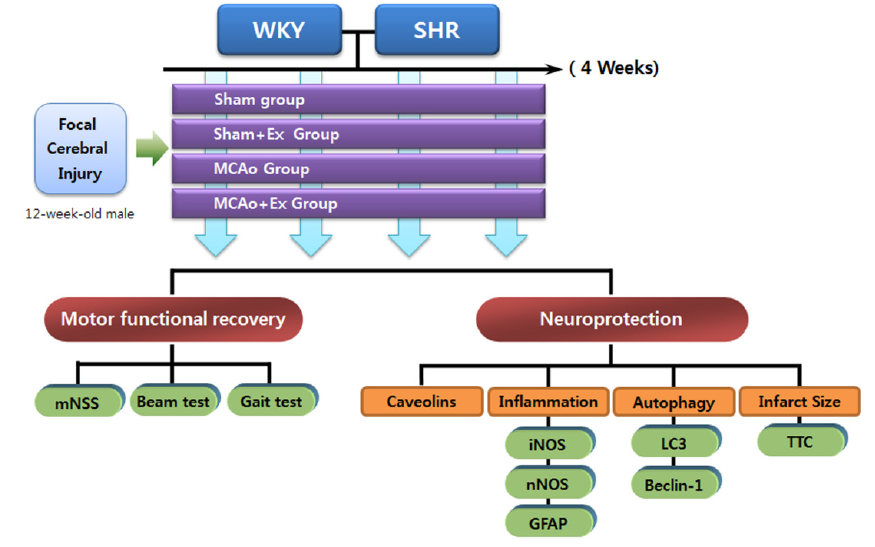
Figure 6. Schematic diagram of experimental design. WKY and SHR rats were randomly divided into four groups: Sham, Sham + Ex, MCAo, and MCAo + Ex groups. The brain tissue of the core infarction region was analyzed for expression of caveolins, inflammatory activation markers (NOS isoforms (iNOS and nNOS) and GFAP), and mediators of autophagic cell death (LC3 and beclin-1). Motor dysfunction due to MCAo was also